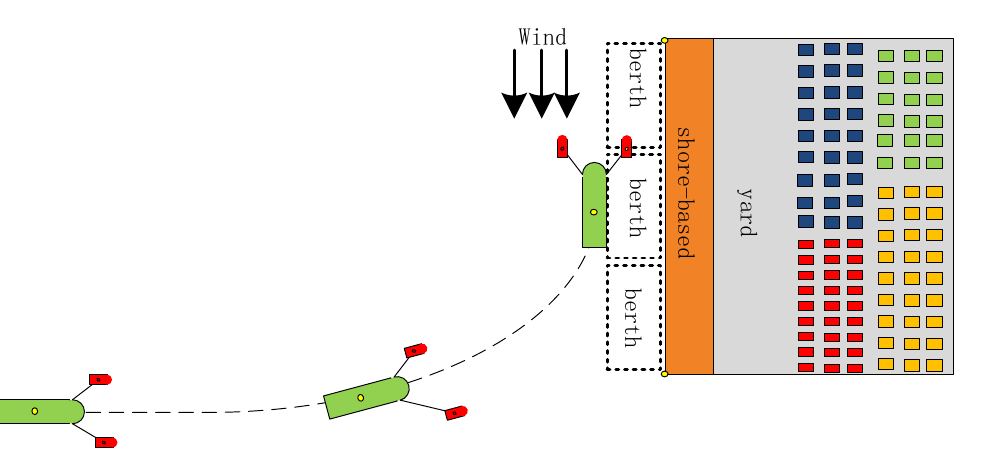
Figure 1. Schematic diagram of tugboat assisting ship maneuvering.